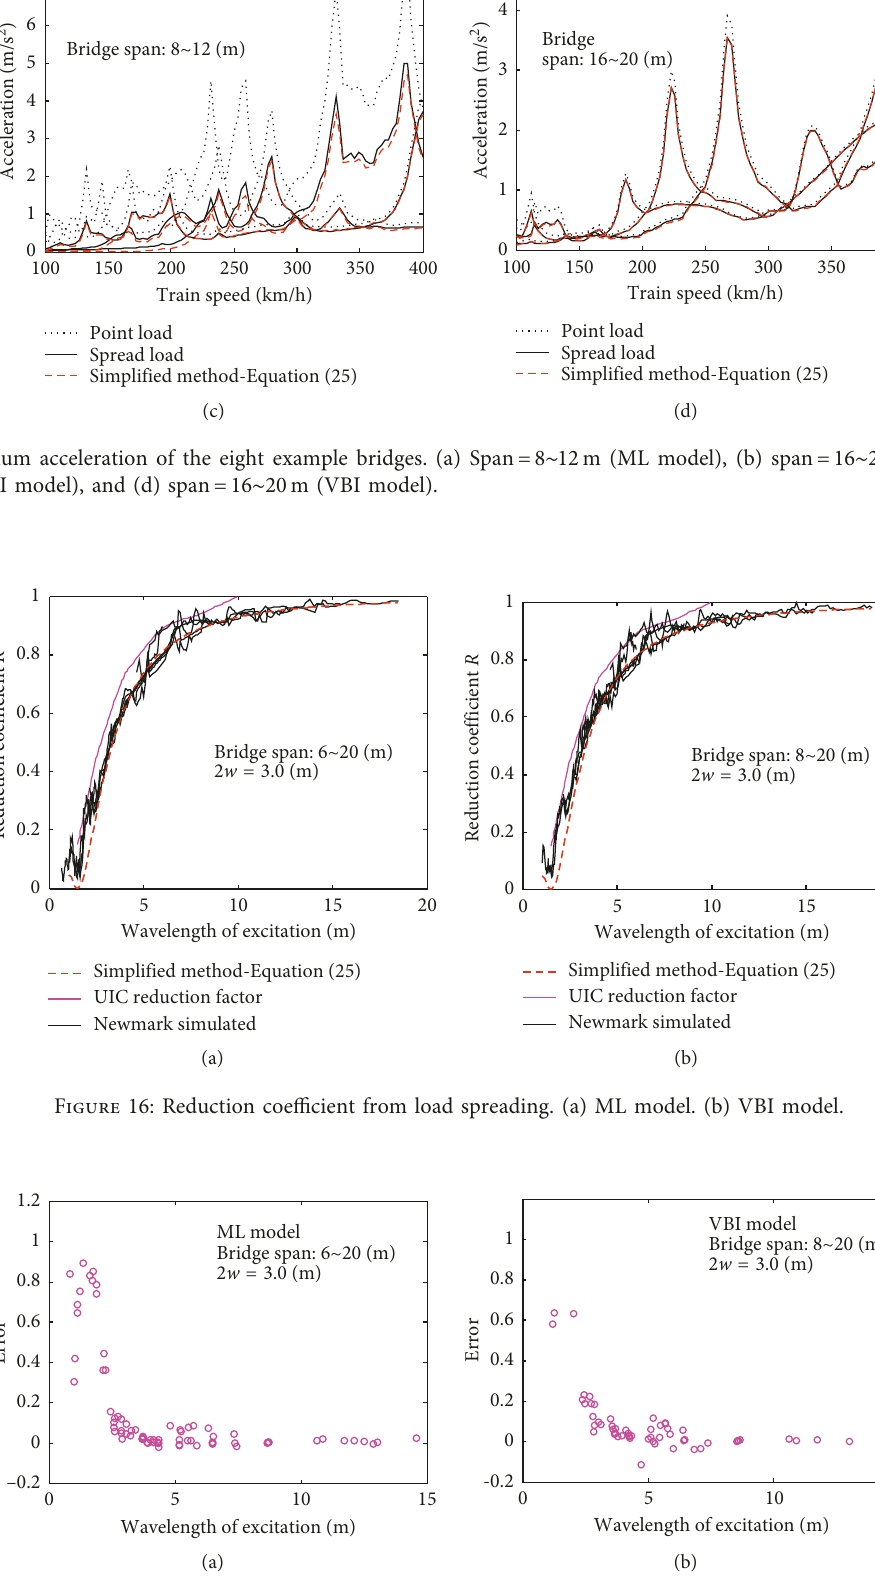
Figure 17: Relative error of the reduction coefficient